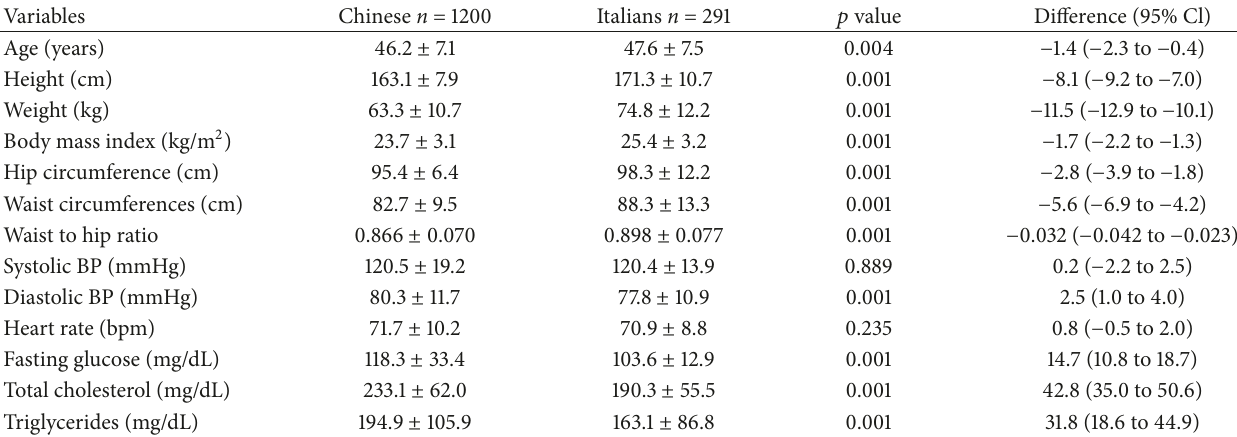
Values are mean ±